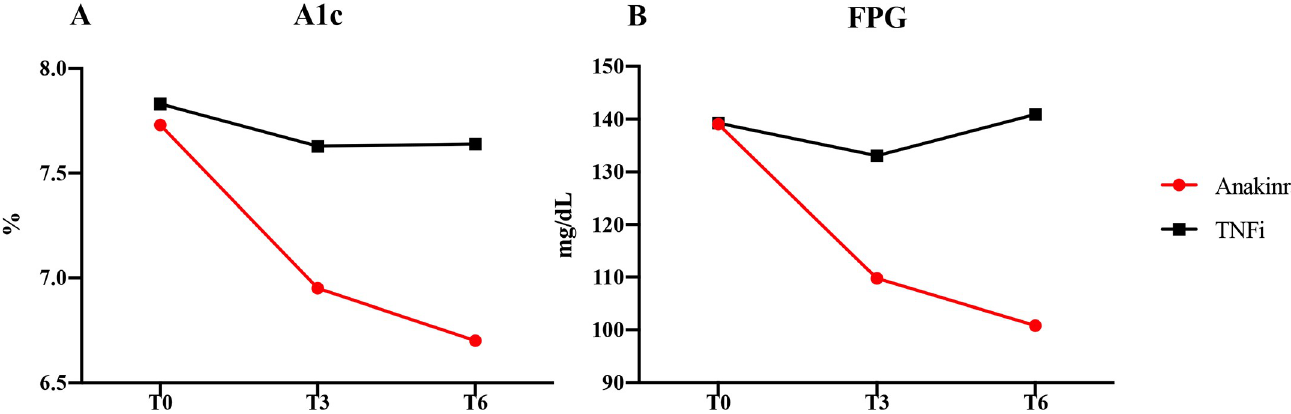
Fig 2. Measures of glycaemic control and bodyweight. Metabolic measures of glycaemic control at baseline (T0) and after 3 (T3) and 6 (T6) months of treatment with anakinra or TNFi. (A) HbA1c%. T0: anakinra group (7.73% ± 0.67) versus TNFi group (7.83% ± 0.76); T3: anakinra group (6.95% ± 0.61) versus TNFi group (7.63% ± 0.68), p = 0.0038; T6: anakinra group (6.70% ± 0.67) versus TNFi group (7.64% ± 0.65), p < 0.001. (B) FPG. T0: anakinra group (139.05 ± 50.09 mg/dL) versus TNFi group (139.25 ± 29.55 mg/dL); T3: anakinra group (109.78 ± 30.58 mg/dL) versus TNFi group (133.06 ± 27.72 mg/dL), p = 0.027; T6: anakinra group (100.81 ± 11.11 mg/dL) versus TNFi group (140.93 ± 39.45 mg/dL), p < 0.001. FPG, fasting plasma glucose; HbA1c%, percentage of glycated haemoglobin; TNFi, tumour necrosis factor